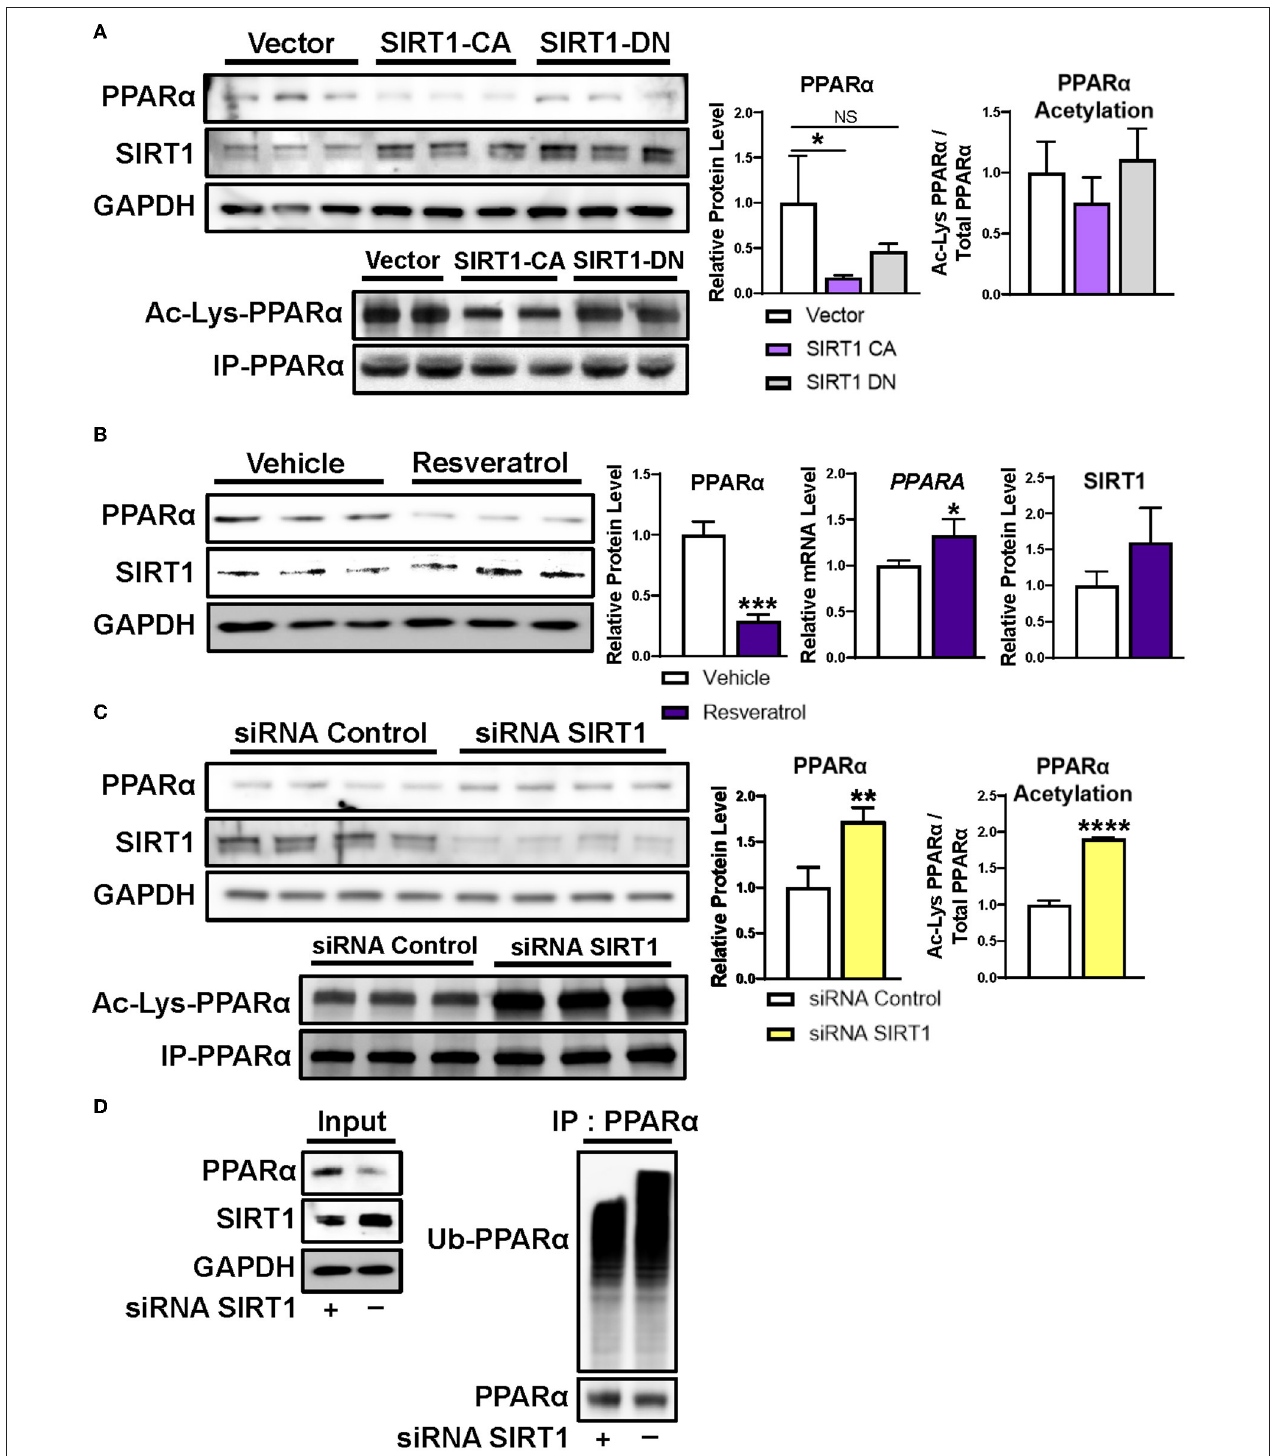
FIGURE 3 | Regulation of PPAR α protein level by SIRT1. (A) Transient transfection of human-derived HepG2 hepatocellular carcinoma cells with constitutively active SIRT1 decreased PPAR α protein levels and acetylation, whereas transfection with dominant negative SIRT1 did not. (B) Incubating HepG2 cells with 100 µ M of the natural SIRT1 activator resveratrol decreased PPAR α protein and increased PPAR α mRNA, similar to our mouse model of undernutrition. (C) Silencing SIRT1 in HepG2 cells increased PPAR α protein and acetylation and (D) decreased ubiquitination of PPAR α . Mean + SD; n = 3–4; **** P < 0.0001; *** P < 0.001; ** P < 0.01; *adjusted P < 0.05. CA, constitutively active; DN, dominant negative; GAPDH, glyceraldehyde 3-phosphate dehydrogenase; IP, immunoprecipitation; NS, not significant; PPAR α , peroxisome proliferator-activated receptor- α ; siRNA, small interfering RNA; SIRT1, NAD-dependent deacetylase sirtuin-1; Ub-PPAR α , ubiquitinated PPAR α .